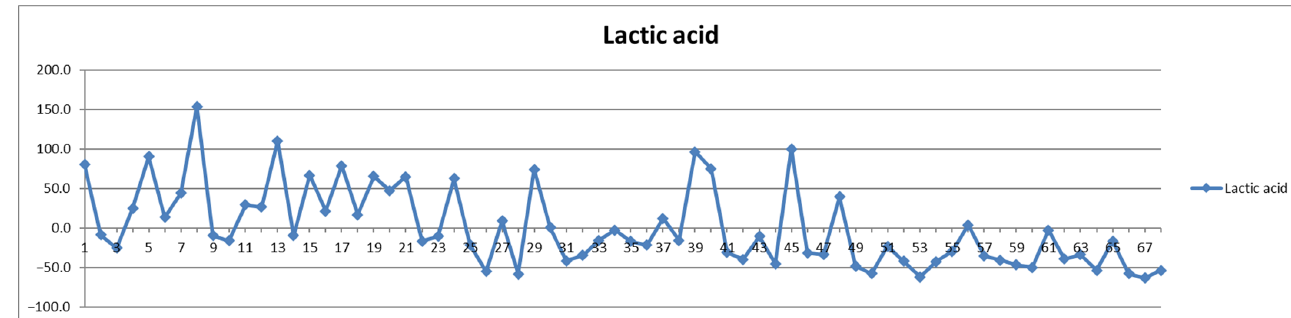
Figure 2. The food intake effect on lactic acid metabolism as difference between postprandial and fasting concentrations as percentage relative to fasting concentration.